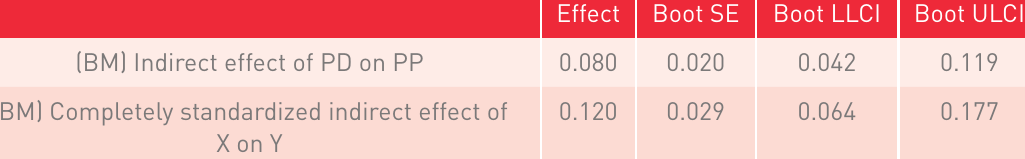
Bootstrap results (BM) Indirect effect of PD on PP 0.080